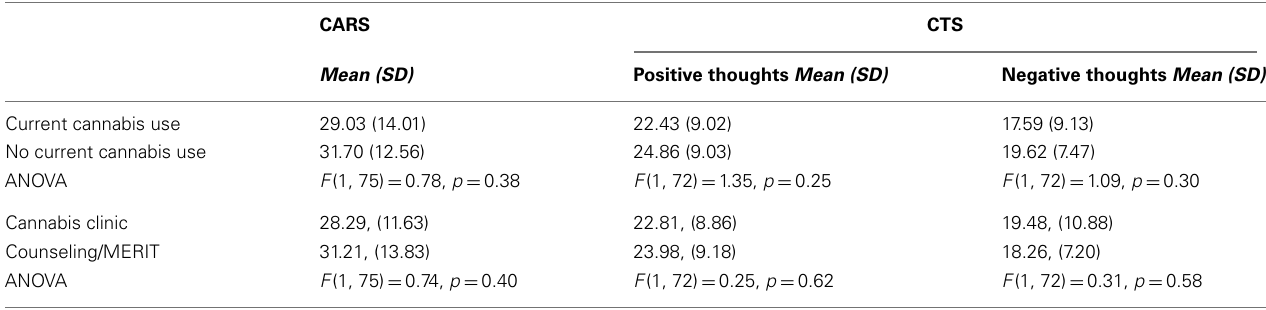
Table 8 | Responses to the ComputerAnxiety Rating Scale (CARS) and the ComputerThoughts Survey (CTS) as a function of current/non-current cannabis* use and Cannabis Clinic versus Counseling/MERIT participants #